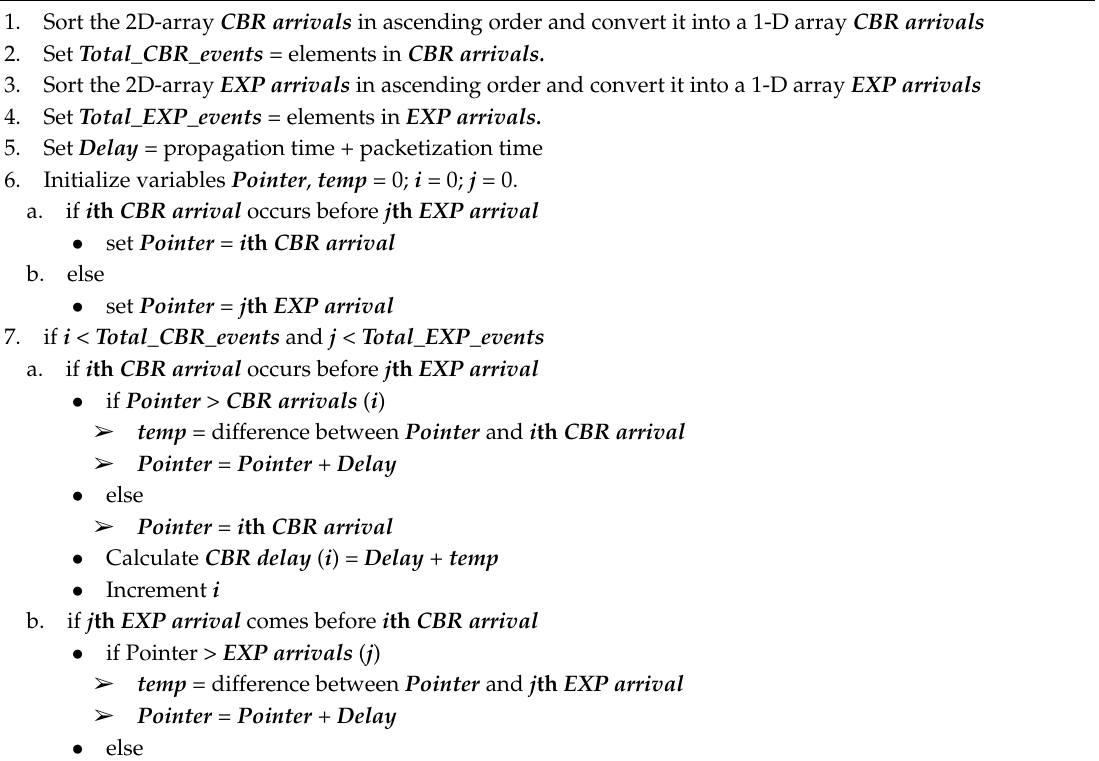
Algorithm 2. FCFS and Corresponding Delay